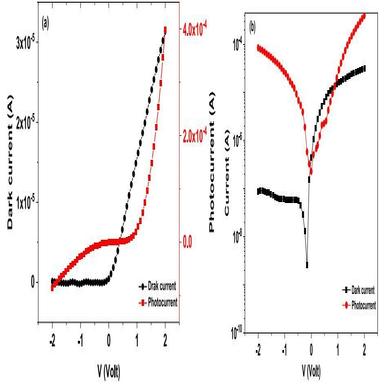
(a) Plot of Current-voltage characteristics, and (b) Plot of semi-logarithmic current vs. V of PVA/p-Si heterojunction.